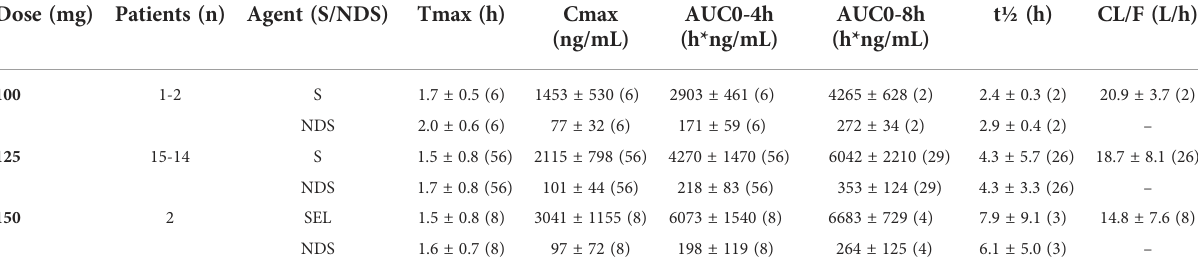
TABLE 5 Pharmacokinetic analysis of selumetinib (S) and N-desmethyl-selumetinib (NDS). Dose (mg) Patients (n) Agent (S/NDS)